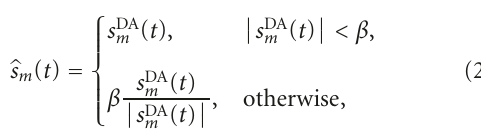
Figure 3: DA converter and HPA input-output